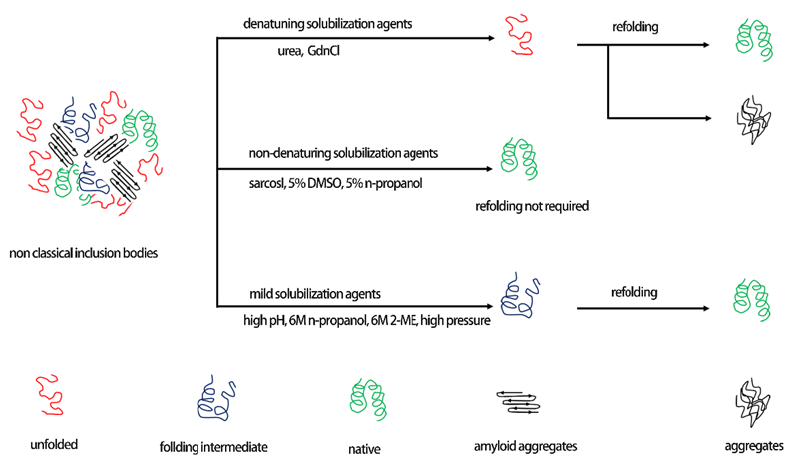
Figure 5. Model showing different solubilization methods used for the recovery of proteins from inclusion inclusion bodies.